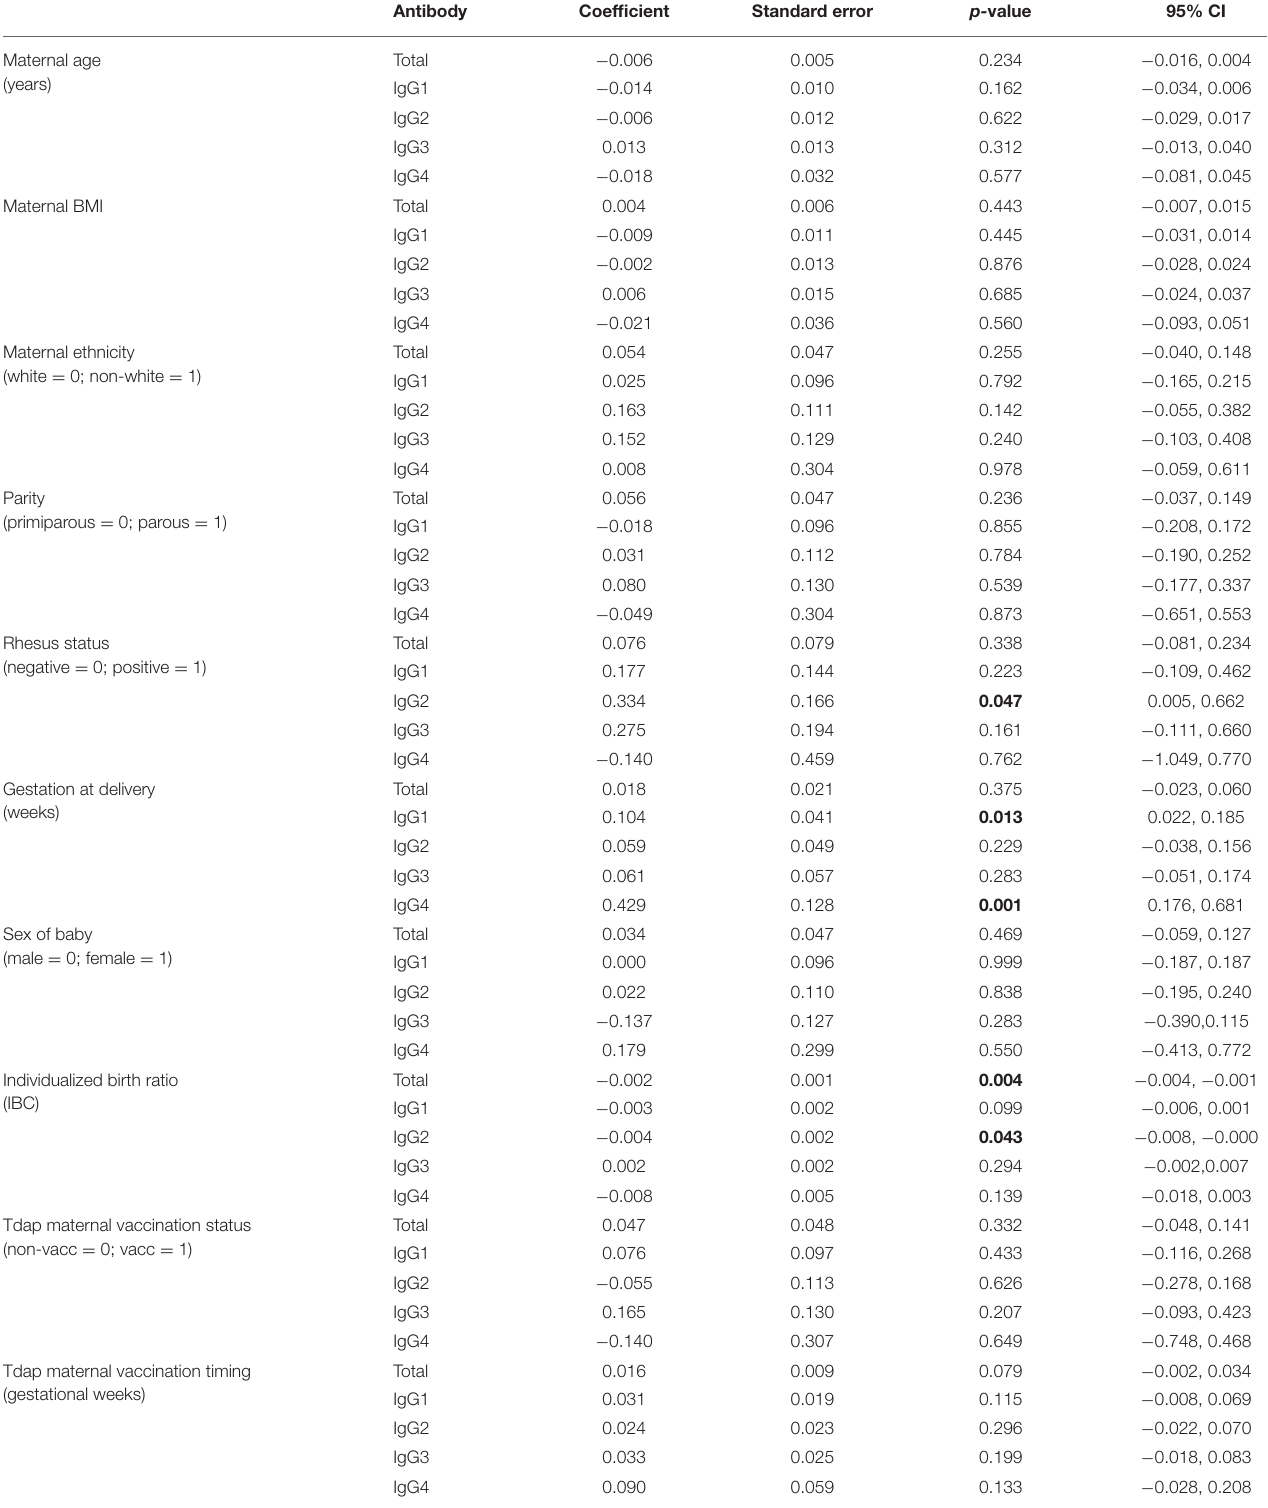
TABLE 3 | Unadjusted effects of clinical parameters on umbilical cord antibody concentrations using simple linear regression based on n = 106 for total IgG and n = 116 for IgG subclasses.